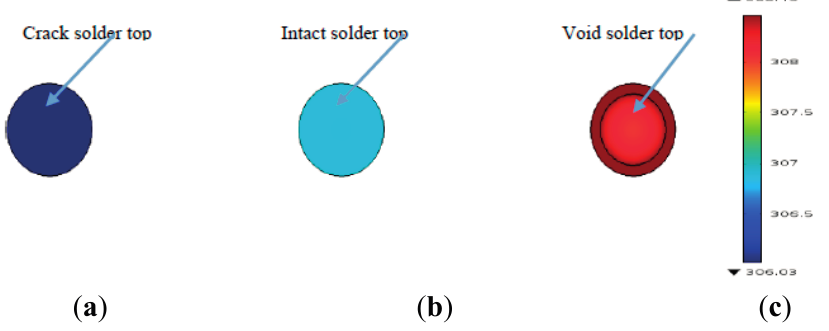
Figure 4. The upper surface temperature images of three solder ball types: ( a ) Crack solder top; ( b ) Intact solder top; ( c ) Void solder top.